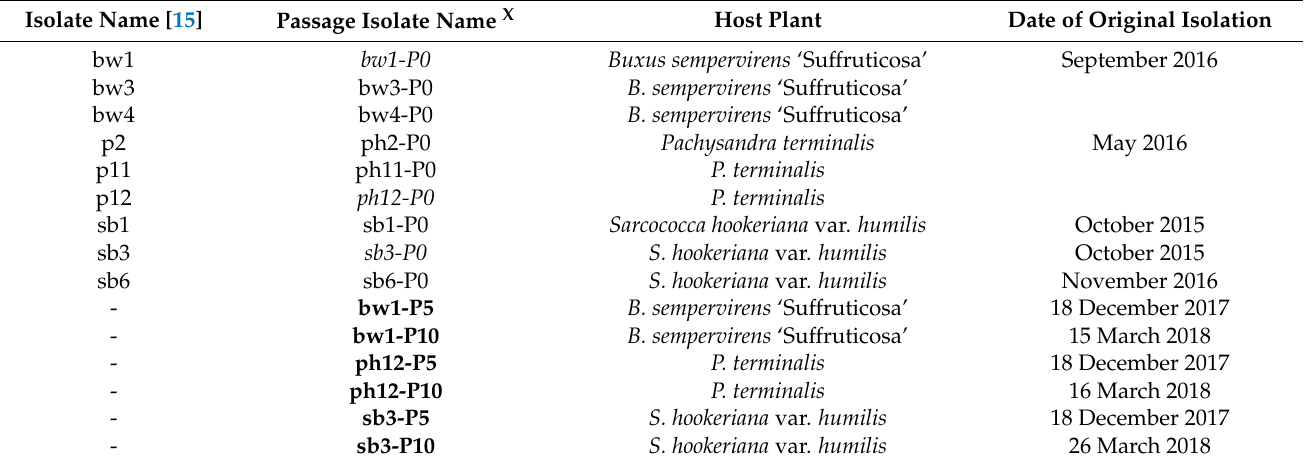
Table 1. Isolates of Calonectria pseudonaviculata used and generated in this